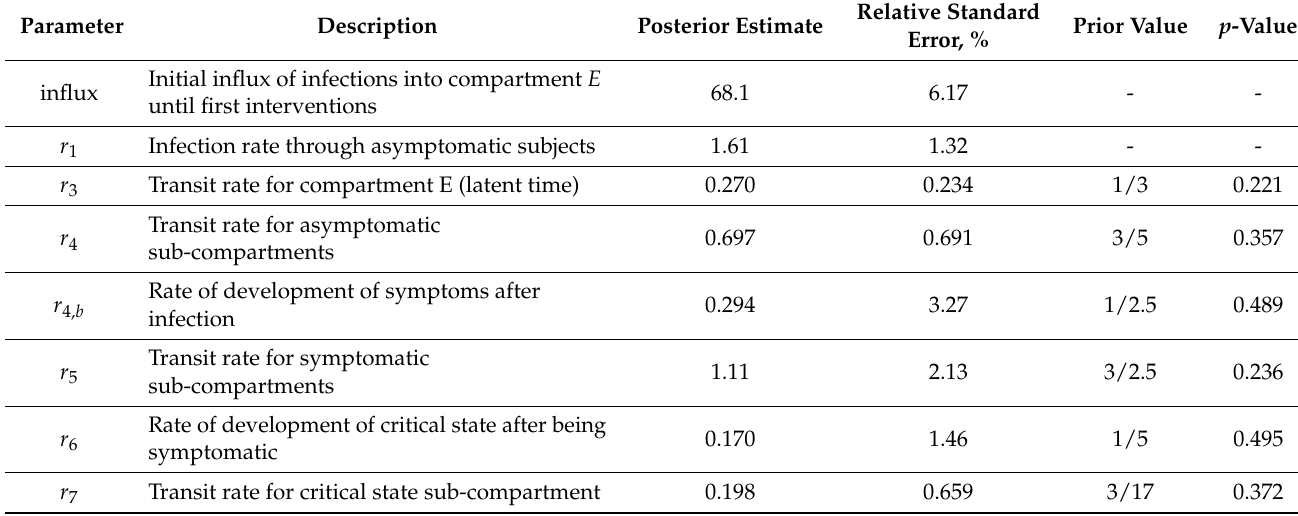
Table A8. Parameter estimates and comparison with average priors for the parameter settings for Saxony. We present estimated parameters of the SECIR model and initial conditions of control parameters and their respective standard errors for the parametrization of the epidemic in Saxony. We also perform a formal comparison of estimates and expected priors using t